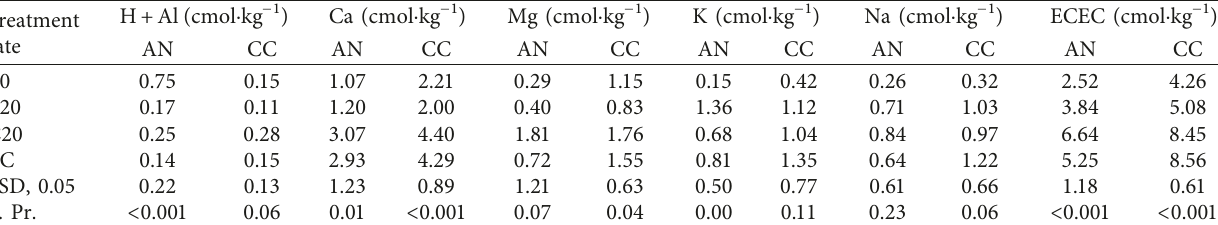
Table 4: Changes in soil chemical properties of the Aiyinase and Cape Coast soils (exchangeable acidity, exchangeable cations, and ECEC) following application of biochar and/or compost 14 days after incubation.